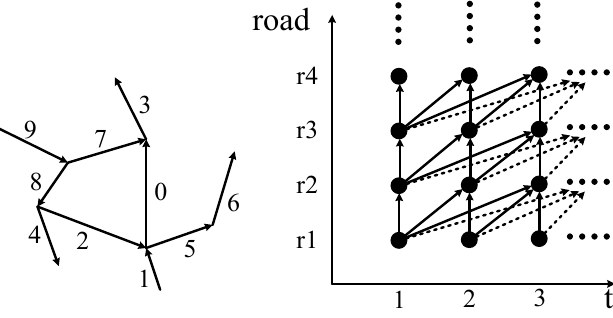
Figure 3. The left diagram shows a road network structure, and the right diagram depicts the relationship of the STRs. The abscissa and ordinate represent different starting times and roads, respectively. The arrows represent the connection between two STRs. As shown in the right subgraph of Figure 3, each road will have an impact on the current and future traffic states of its adjacent roads. The specific impact time is calculated according to different traffic conditions.